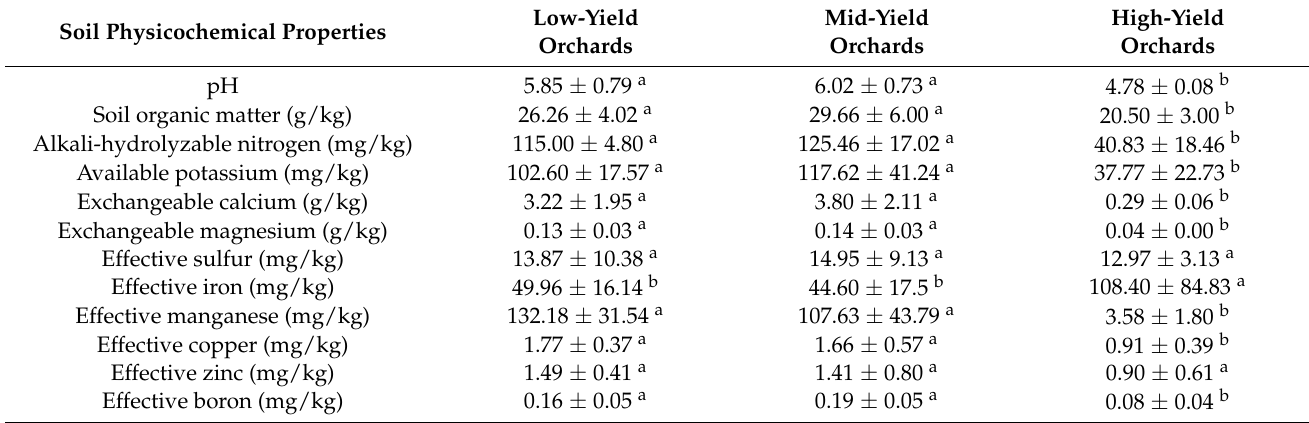
Table 1. The soil physicochemical properties of the mango orchards with different